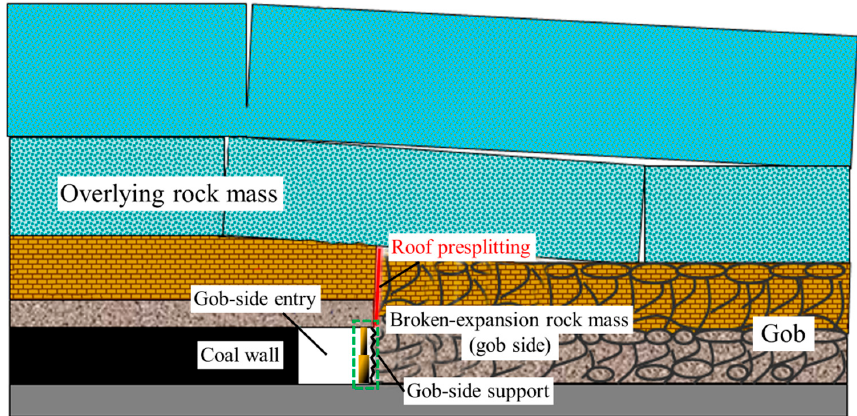
Figure 4. Schematic diagram of the RPGER approach.